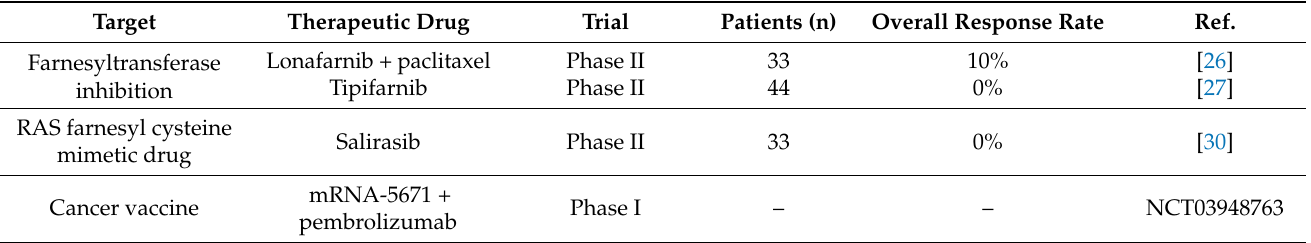
Table 1. Indirect KRAS inhibition—targeting KRAS membrane associations and cancer